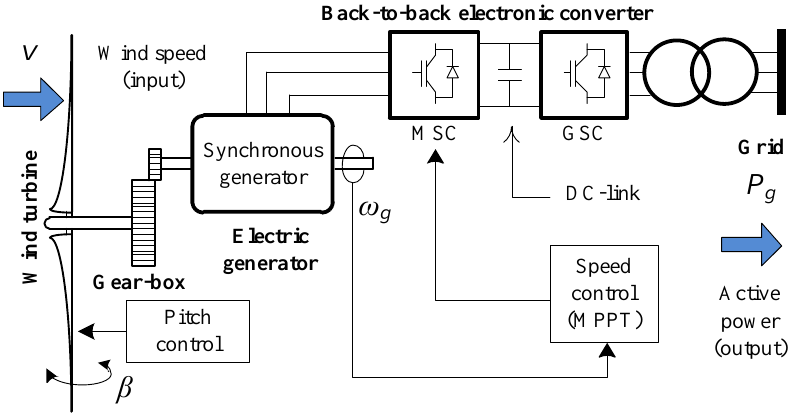
Figure 5. General scheme of the variable speed wind turbine.